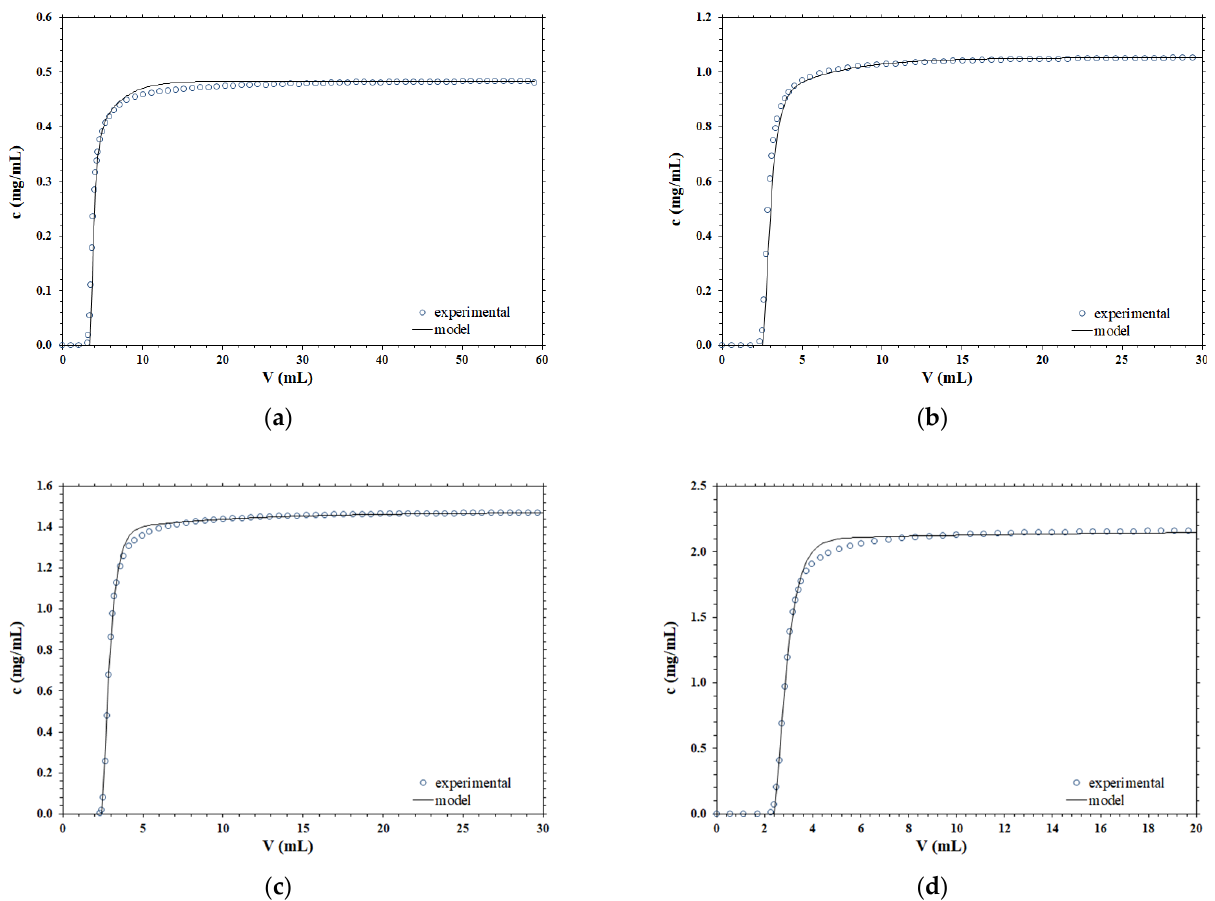
Figure 1. Comparison between the experimental and simulated breakthrough curves at different operating conditions; ( a ) F = 1 mL/min, c 0 = 0.48 mg/mL; ( b ) F = 2 mL/min, c 0 = 1.05 mg/mL; ( c ) F = 5 mL/min, c 0 = 1.47 mg/mL; ( d ) F = 10 mL/min, c 0 = 2.15 mg/mL.